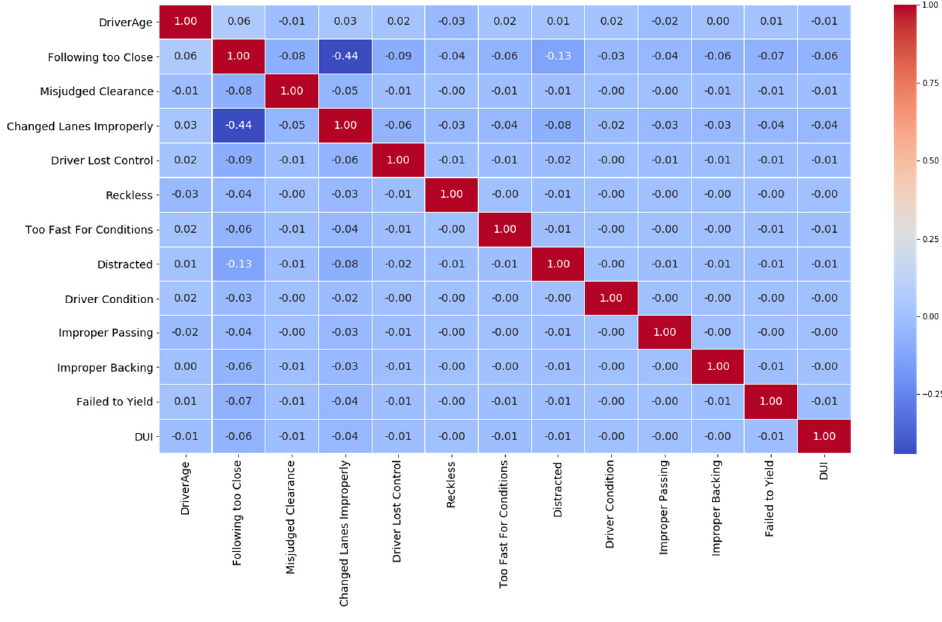
Figure 5. Correlations of driver-related features.